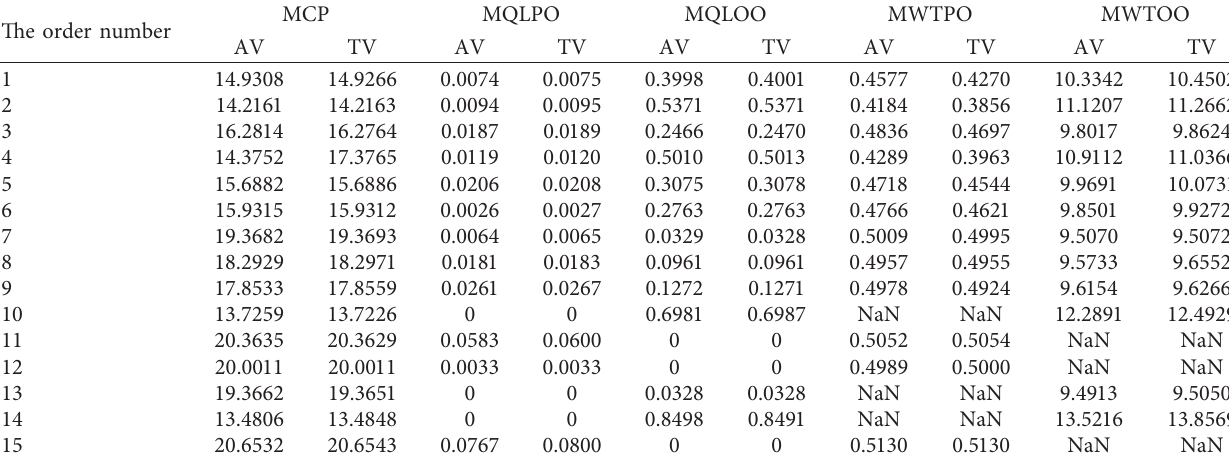
Table 2: Comparison of the numerical results under different order structures.